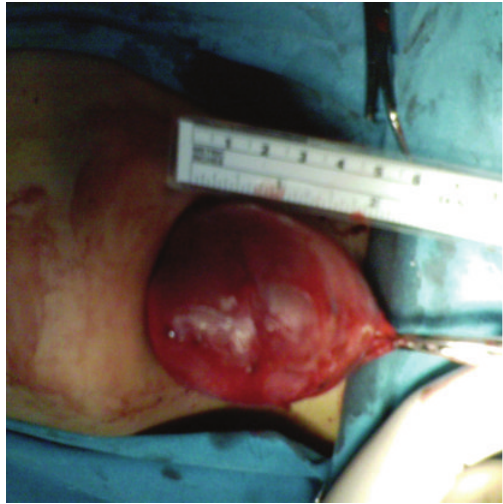
Figure 11: The scintiscan of the area with a Tc 99m showing no evidence of the existence of ectopic thyroid tissue.